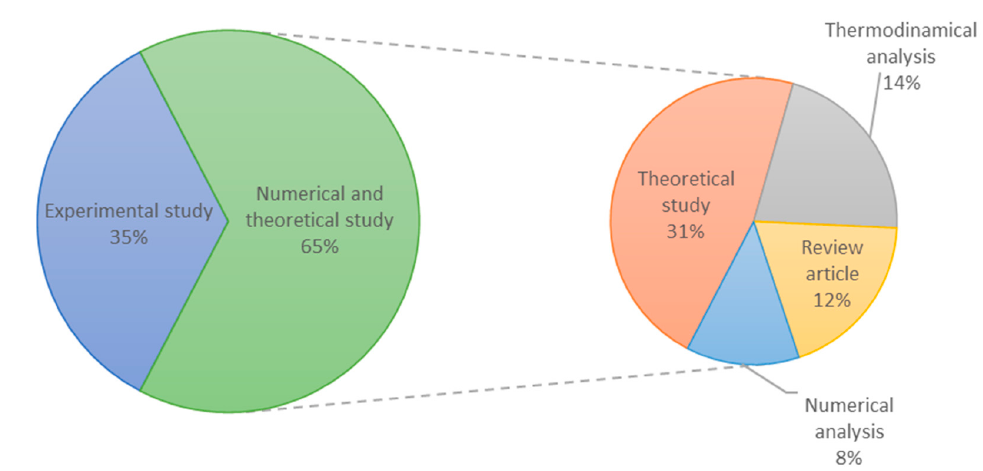
Figure 2. Overview of the articles found in the literature review.